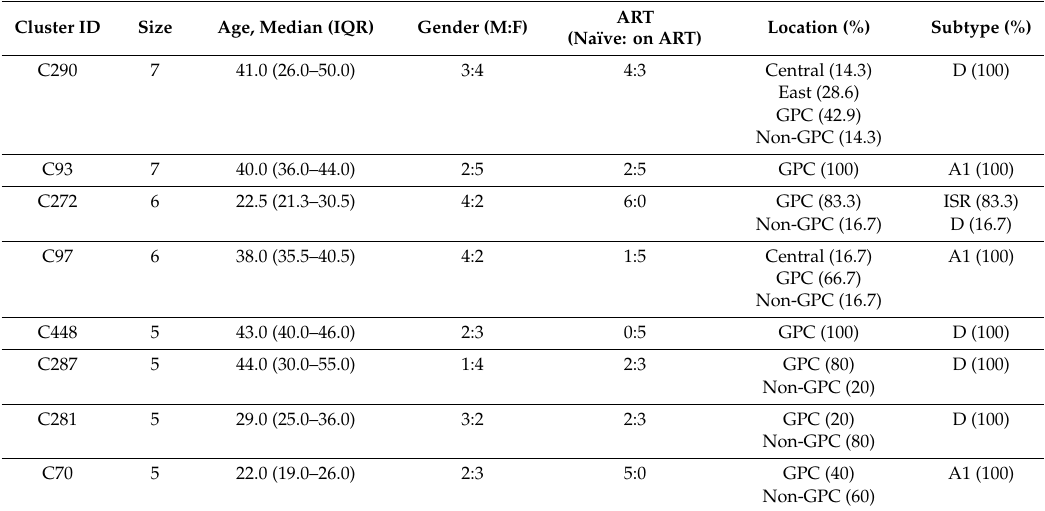
Table 4. Characteristics of clusters of size 5 and